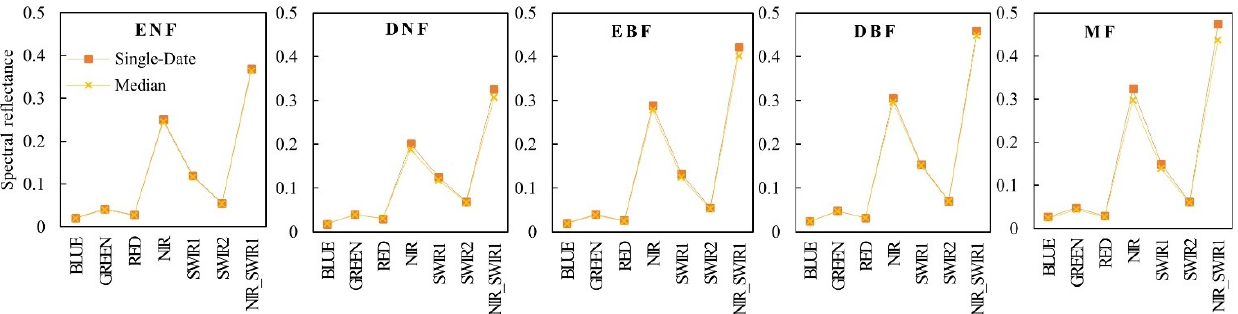
Figure 10. The spectral reflectance curves of five forest type from the summer composite image and the single-date image for summer. The squares represent the values from the single-date image of summer, while the asterisks are the summer reflectance from the composite image.